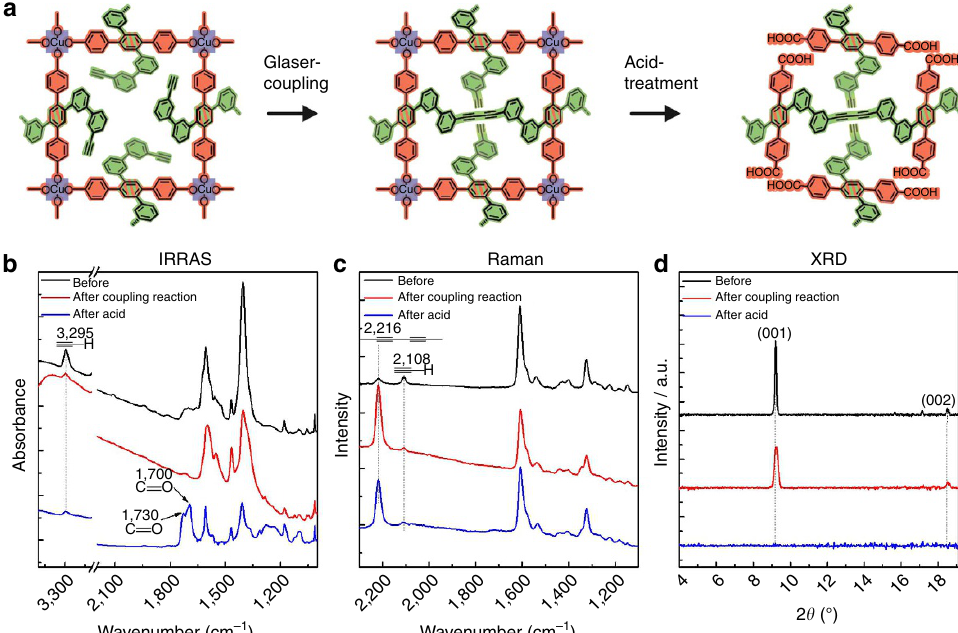
Figure 3 | Formation of molecular textiles. ( a ) Schematic illustration of the formation of molecular weaving in the active MOF layer constructed by BAB- TPDC quadritopic (4t) organic linker. ( b ) IRRAS, ( c ) Raman and ( d ) XRD results collected from the samples with 10 cycles ABAB-SURMOF system with a repeated growth of one layer of BAB-TPDC SURMOFs (MOF-A) and one layer of BMB-TPDC SURMOFs (MOF-B), here one cycle includes one layer of A and one layer of B. In b – d , the initial spectrum is black, the spectrum after coupling is red, and spectrum after acid treatment is